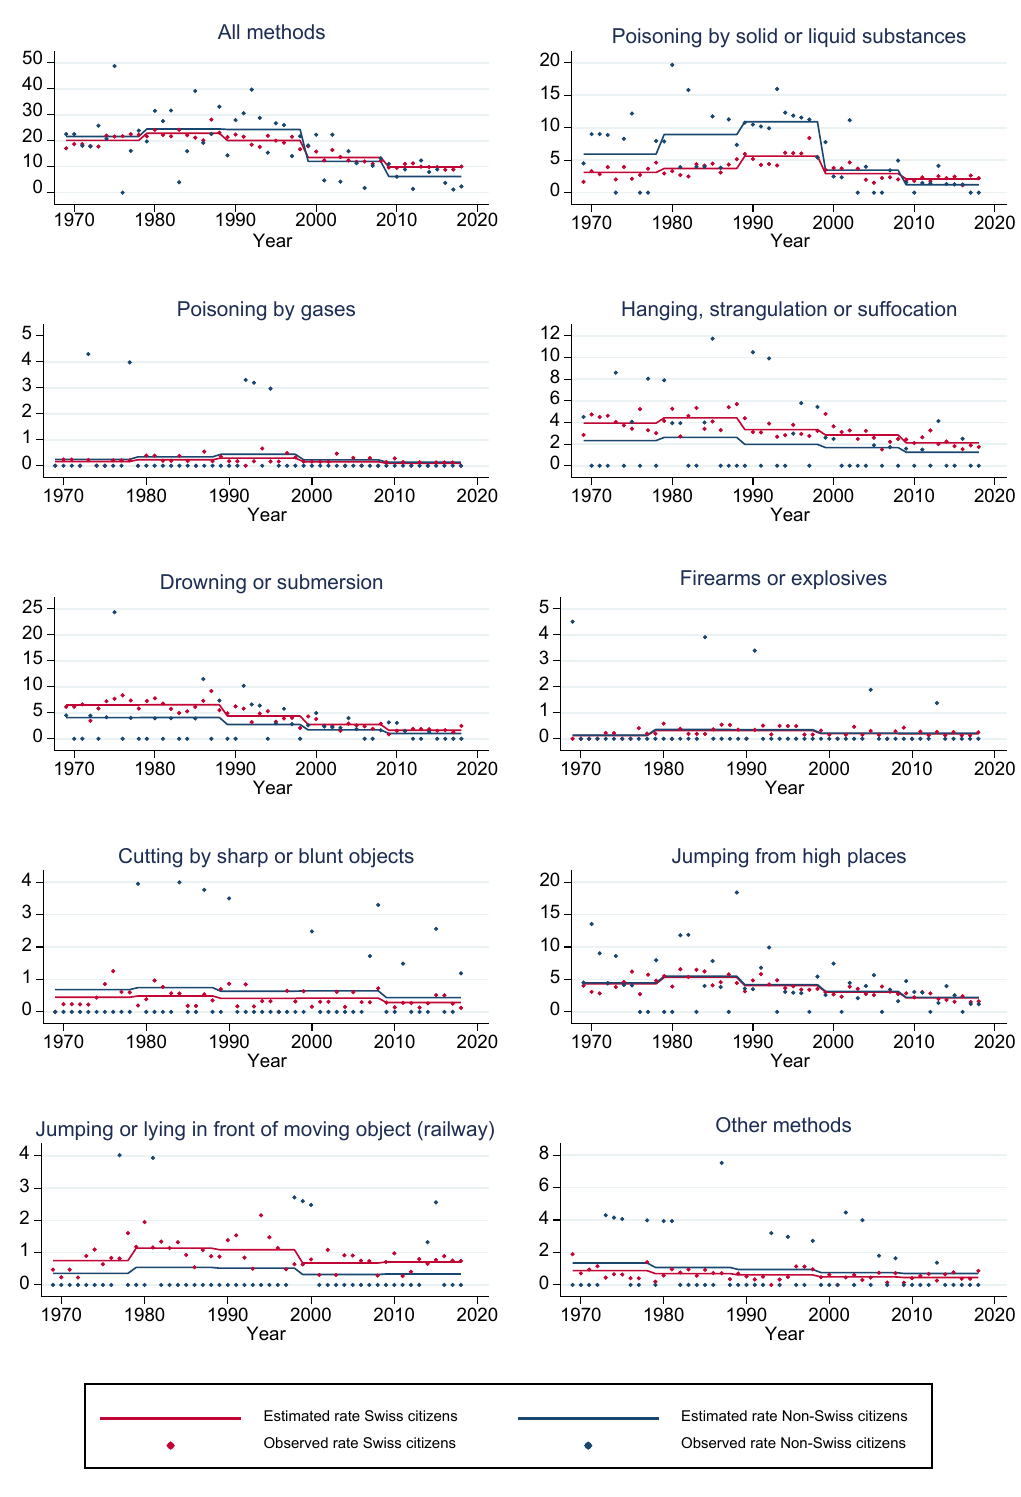
Figure S8. Rates of suicide methods per 100'000 population (person-years) in 65 or more years old